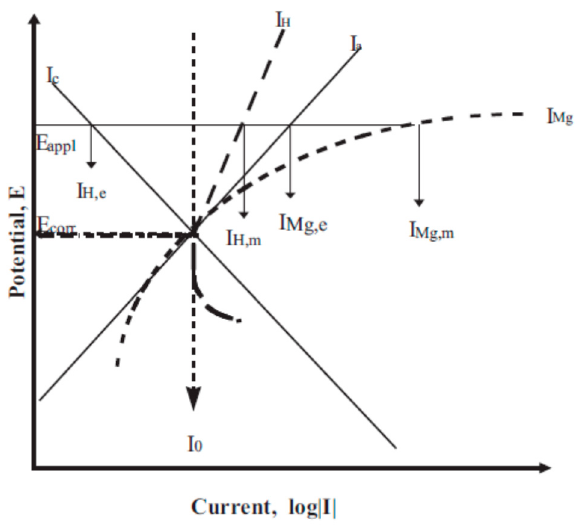
Figure 15. Schematic representation of negative different effect. Reproduced with permission from [118], Elsevier, 1997.